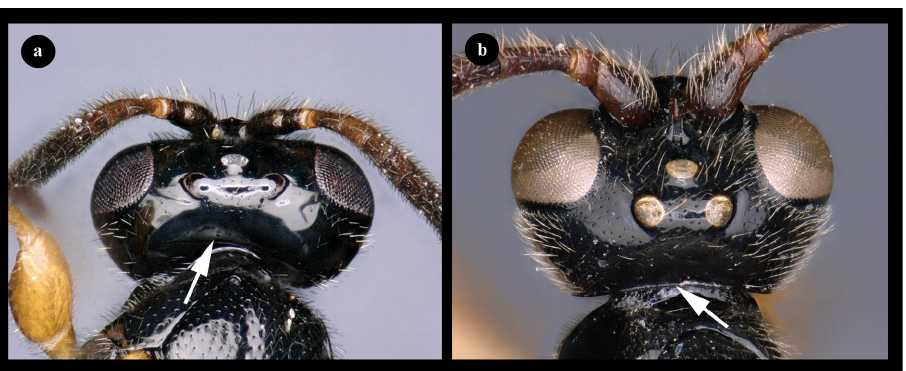
Fig. 9. a . Carria sp., head, dorsal view. b . Hypsicera sp., head, dorsal view. Arrow in Fig. 9a points to the absence of occipital carina (compared to the presence of occipital carina in Fig. 9b).